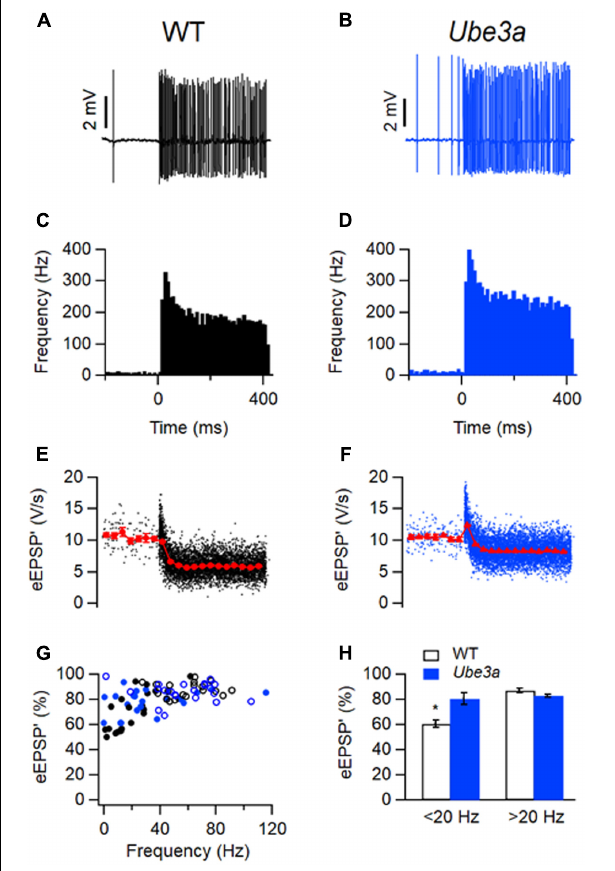
FIGURE 11 | Longer AIS in Ube3a mice. (A) Confocal section of MNTB slice, labeled with anti-CASPR2 (yellow) and anti-ankyrin-G (red) and anti-Vglut1 & 2 (green). The composite image shows a node of Ranvier from a calyceal axon (white arrow head) and a principal cell axon (yellow arrow head), and a calyceal heminode (white arrow), as well as a postsynaptic AIS (yellow arrow). (B) AISs of MNTB cells labeled by anti-ankyrin-G, from both WT and Ube3a animals. (C) Comparison of AIS length in C57BL/6J WT and Ube3a E113X mice. ∗ Indicates p < 0.001. Calibration bars 10 µ m.